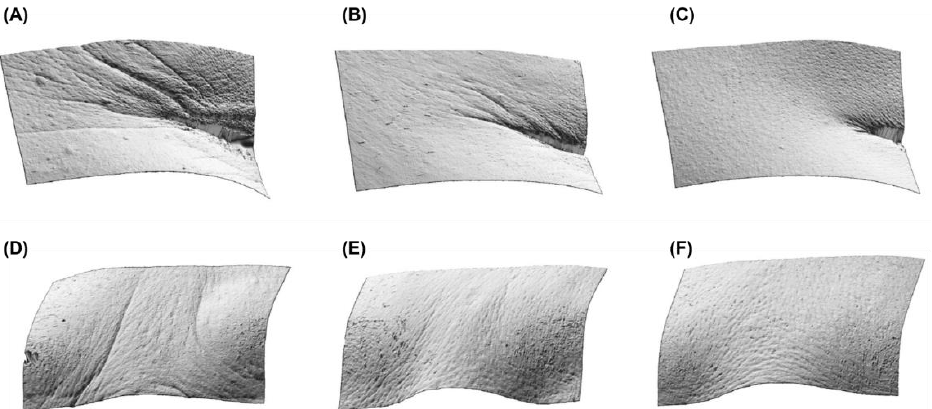
Figure 2. Image of wrinkles by level. The area of eye appears at the high level ( A ), middle level ( B ), and low level ( C ), and the area of glabellar appears at the high level ( D ), middle level ( E ), and low level ( F ).